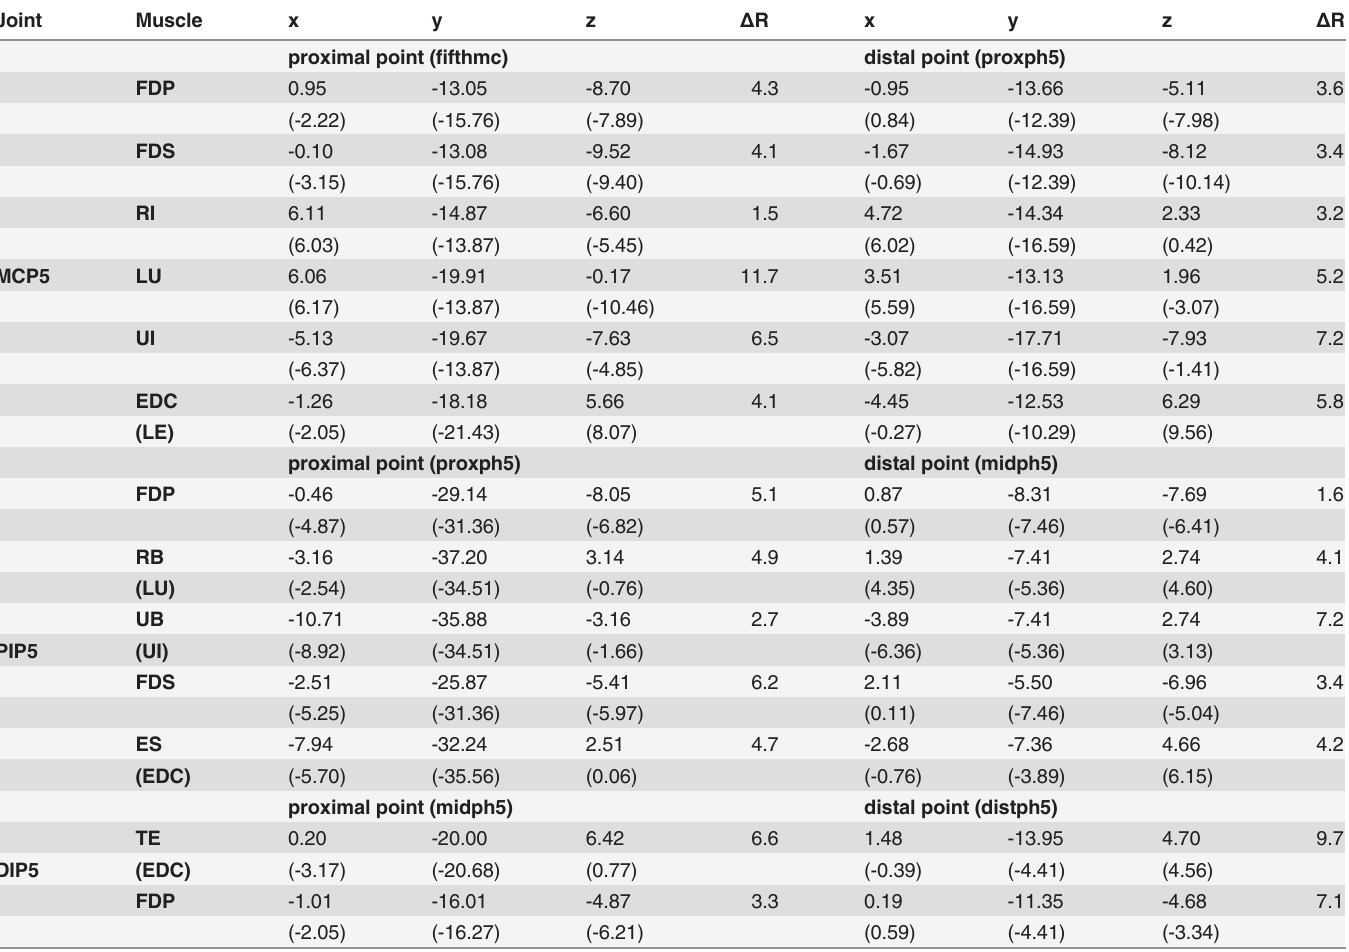
Table 10. Little finger muscle-tendon locations, expressed in OpenSim frame